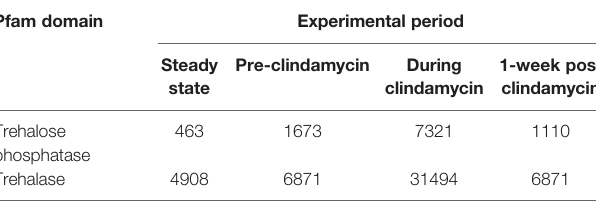
TABLE 1 | Abundance of trehalose speci fi c Pfam domains in model T.